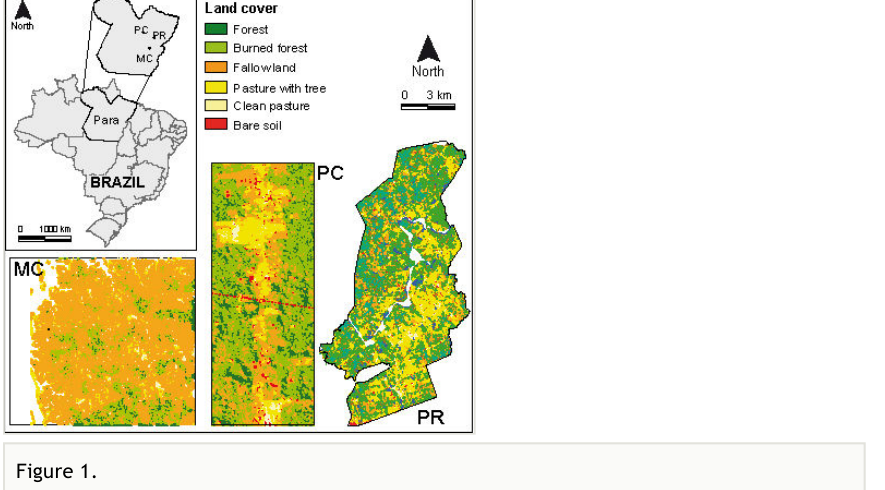
Location of Pará State and the study sites of Maçaranduba (MC), Pacajá (PC) and Palmares II (PR). Coloured areas in the maps represent land use of the study sites in